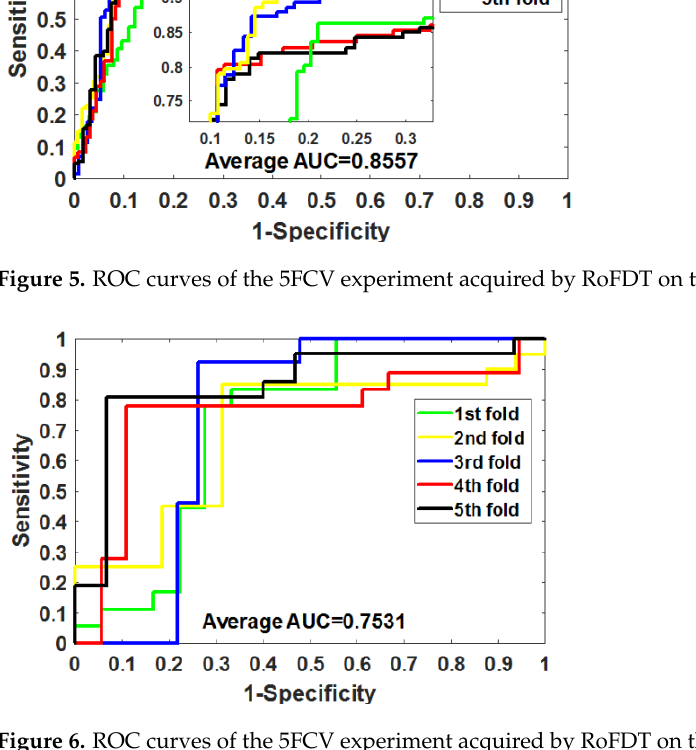
Figure 6. ROC curves of the 5FCV experiment acquired by RoFDT on the Nuclear Receptor da- taset.